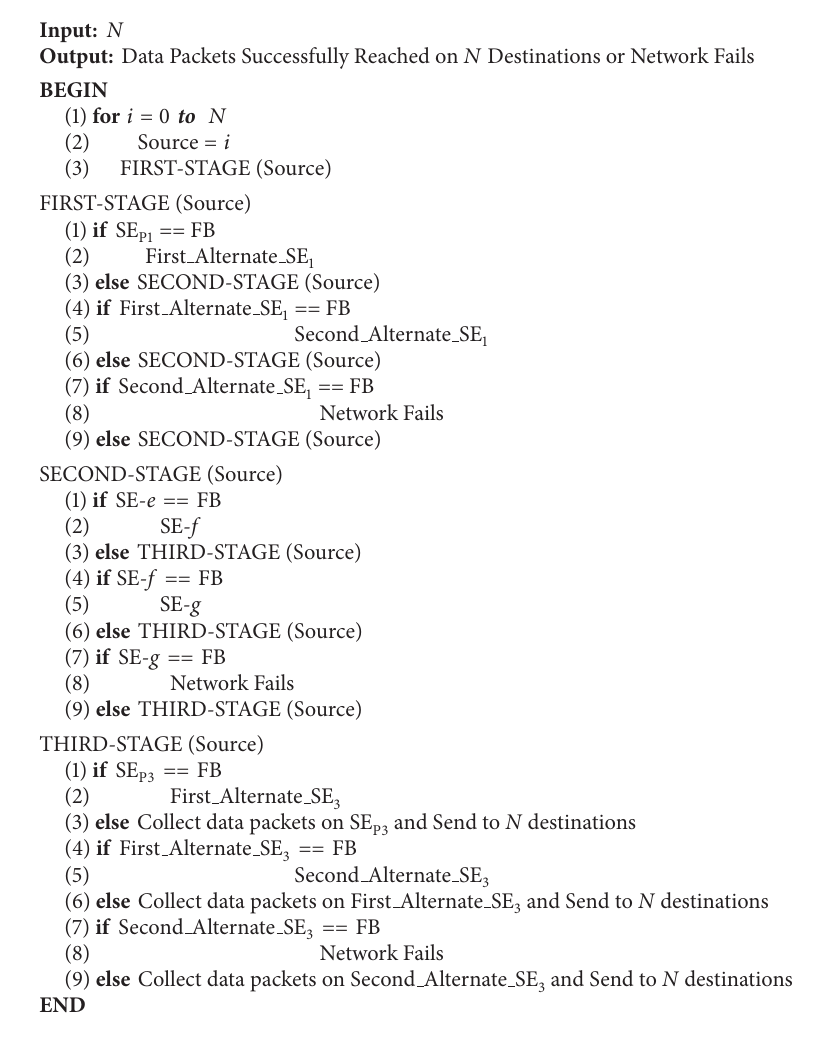
Algorithm 1: Algorithm IAON